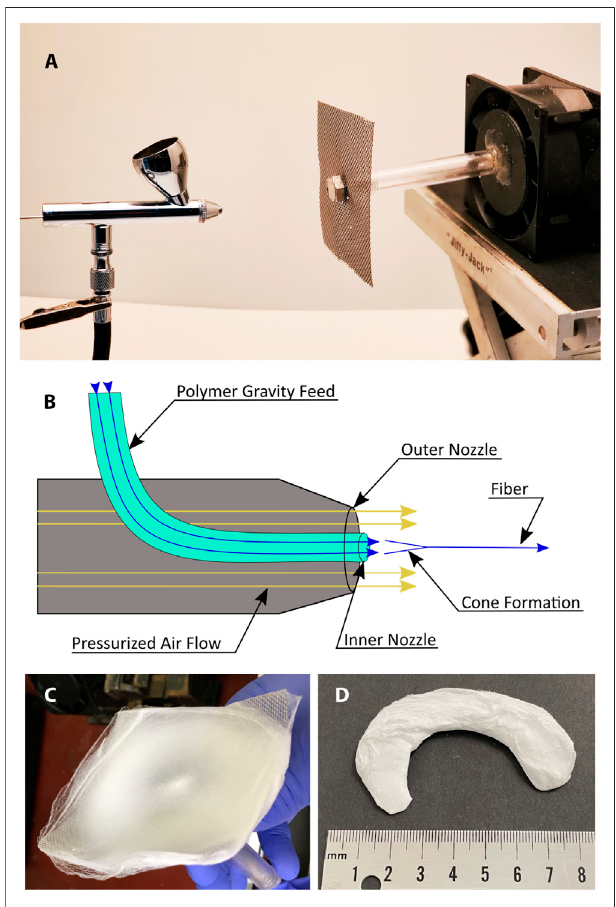
FIGURE 1 | Pneumatospinning setup (A) Photograph of airbrush and mesh collector. (B) Diagram of polymer jet generated by air fl ow. (C) Photograph of scaffold spun on mesh collector. (D) Scaffold cut to the shape of a human